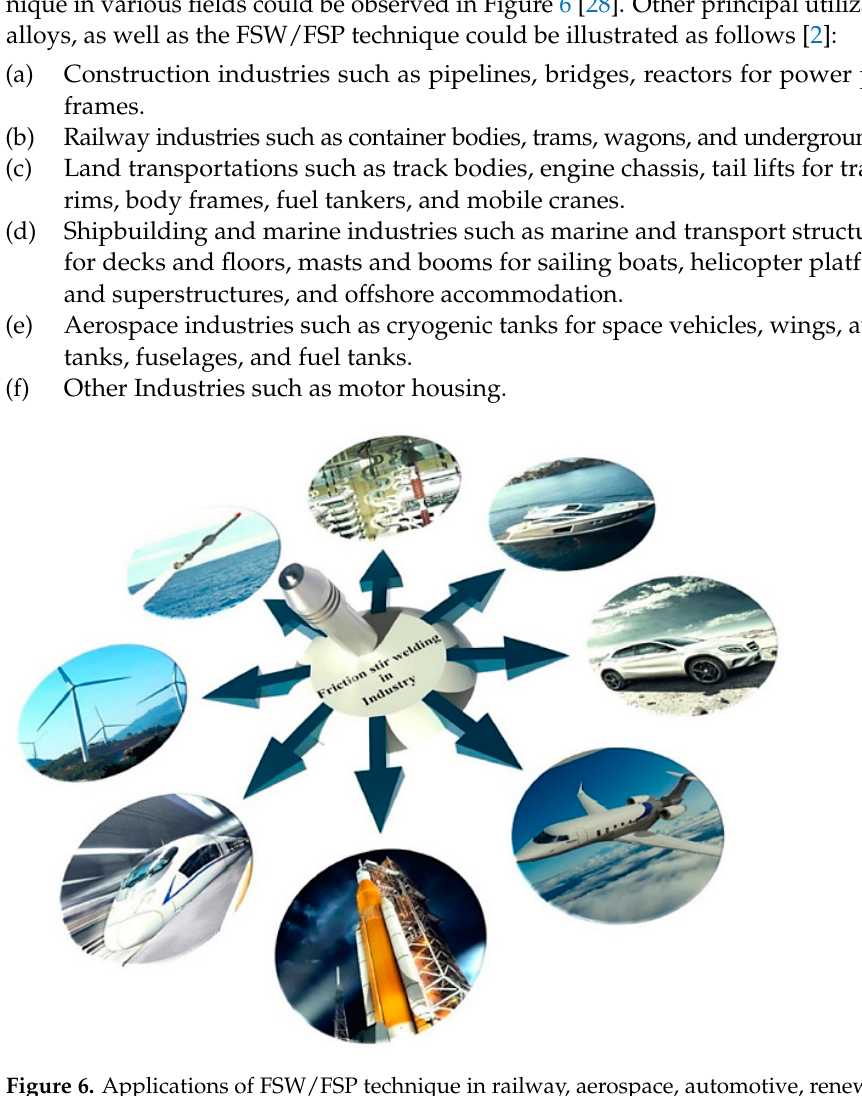
Figure 6. Applications of FSW/FSP technique in railway, aerospace, automotive, renewable energy, shipbuilding and marine, and defense industries [28]. shipbuilding and marine, and defense industries (Reprinted with permission from ref. [28]. Copyright 2020 Elsevier